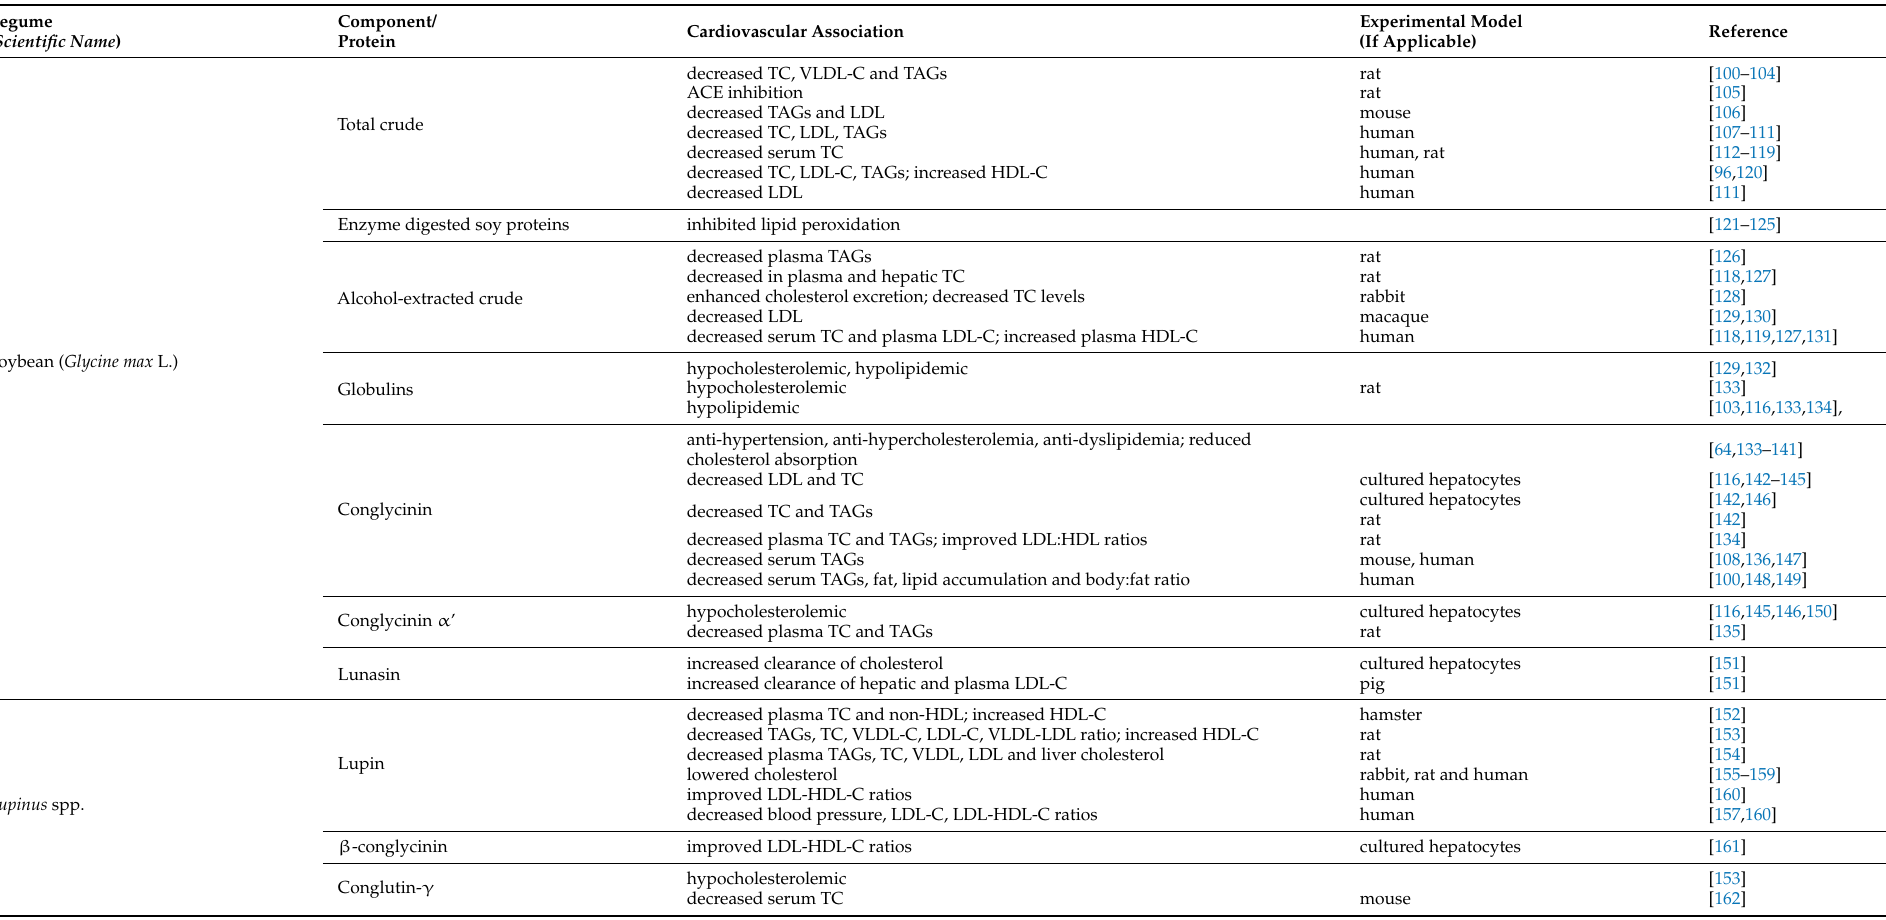
Table 2. Functional protein components of selected legumes associated with cardiovascular-related conditions discussed in this